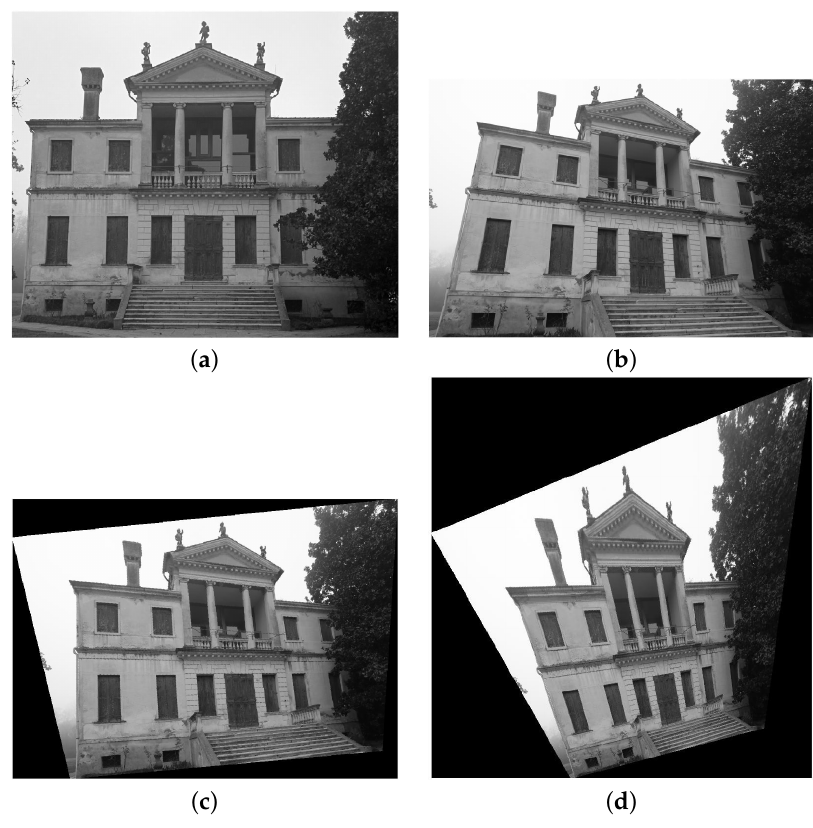
Figure 2. Example of image transformation to improve feature matching when dealing with generic change of the point of view. ( a ) image 1; ( b ) image 2; ( c ) image 1 transformed in order to improve feature matching with image 2; and ( d ) image 1 after applying a transformation not properly related with image